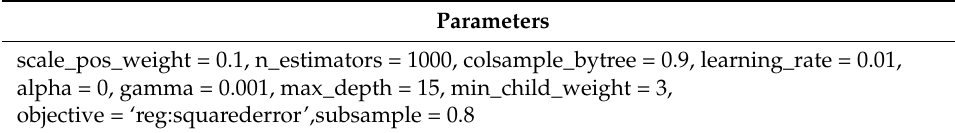
Table 3. Selected parameters for the model of XGBRegressor.